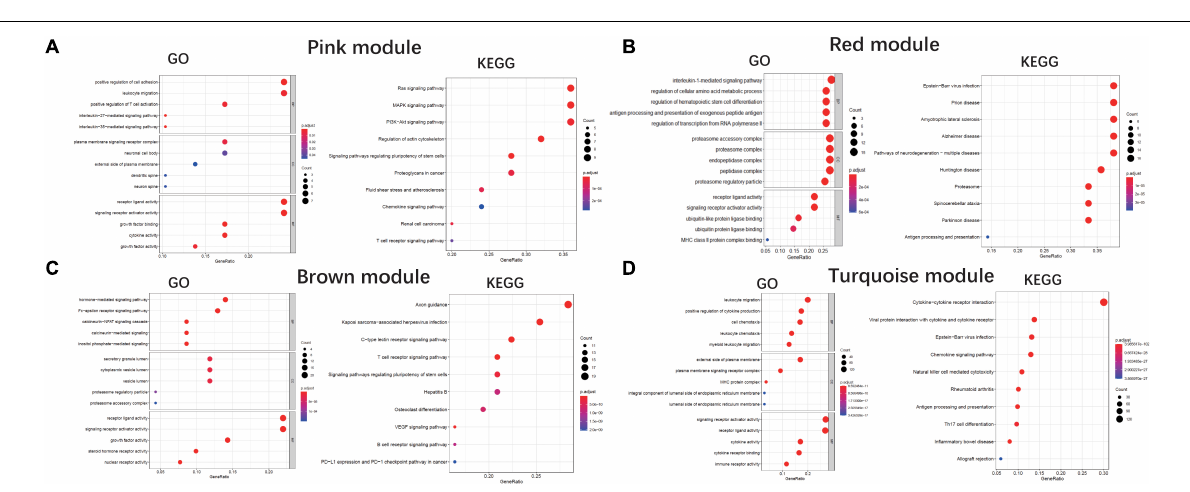
FIGURE 4 | GO and KEGG analysis. Gene Ontology and KEGG enrichment analysis of pink module (A) , red module (B) , brown module (C) , and turquoise module (D) , respectively. The color indicates the adjusted p value, and the size of dots represents the number of the genes. BP, biological process; CC, cellular component; MF, molecular